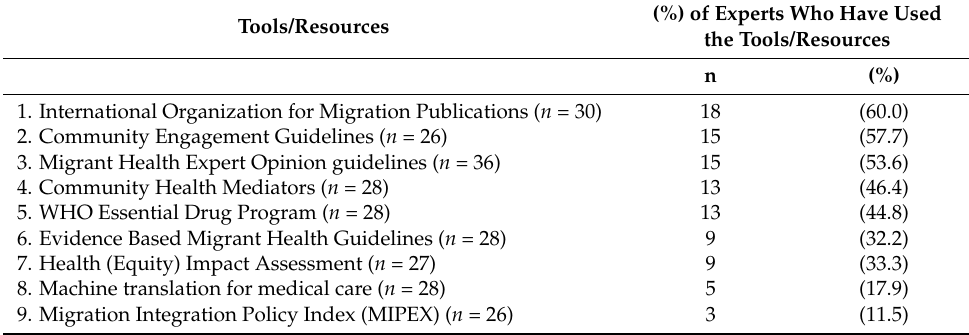
Table A2. Percentage of Stakeholder Usage of Practice Based Resources and Tools for Migration. Tools/Resources